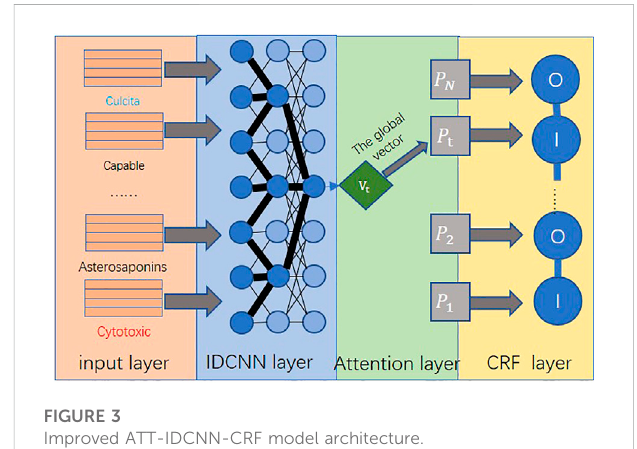
FIGURE 3 Improved ATT-IDCNN-CRF model